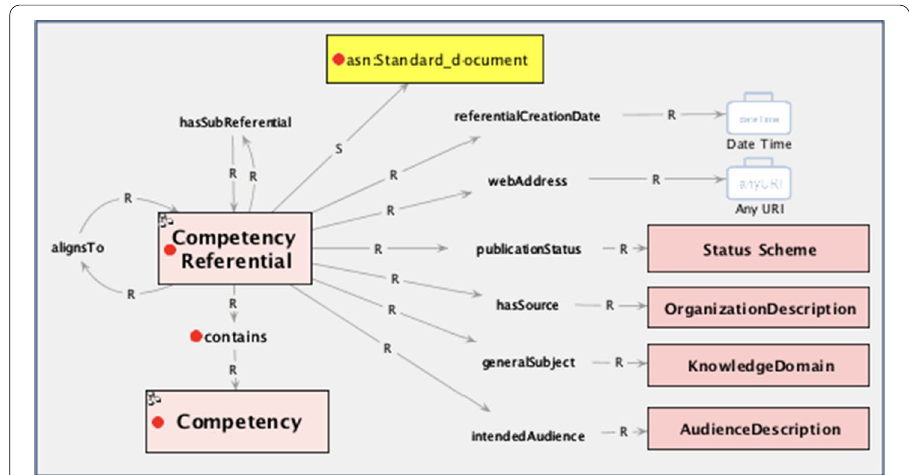
Fig. 7 Competency referential information